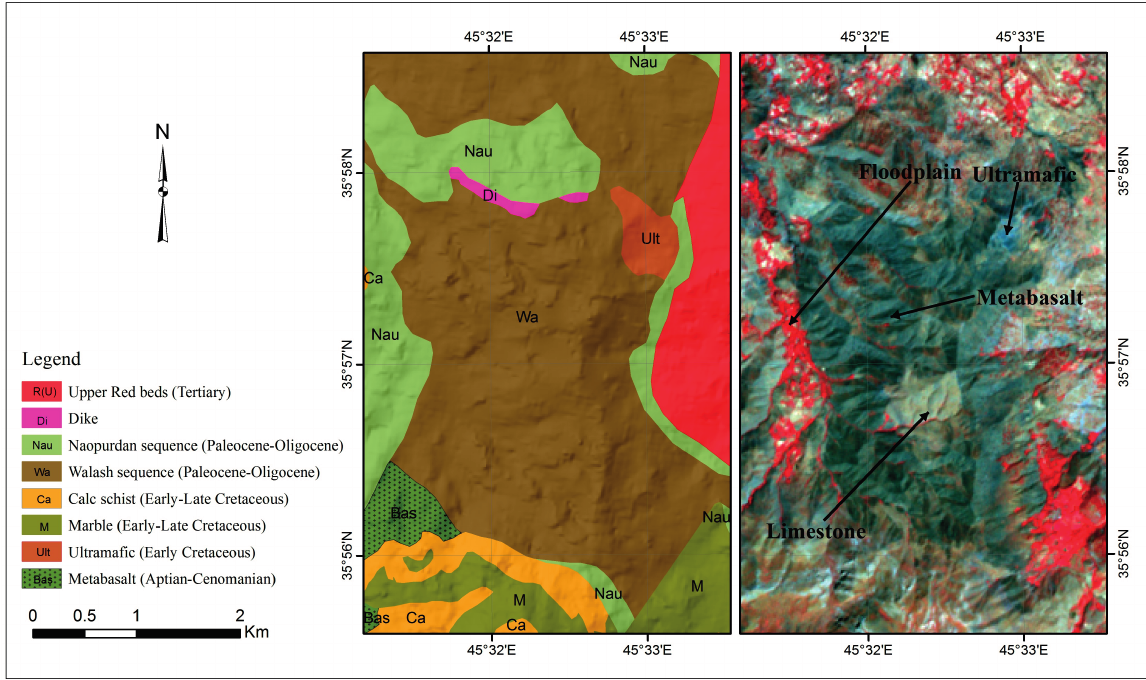
Figure 9. Example of mismatching between the lithological units in the previous geological map and ASTER satellite data R3:G2:B1, acquired on 24 August 2003.